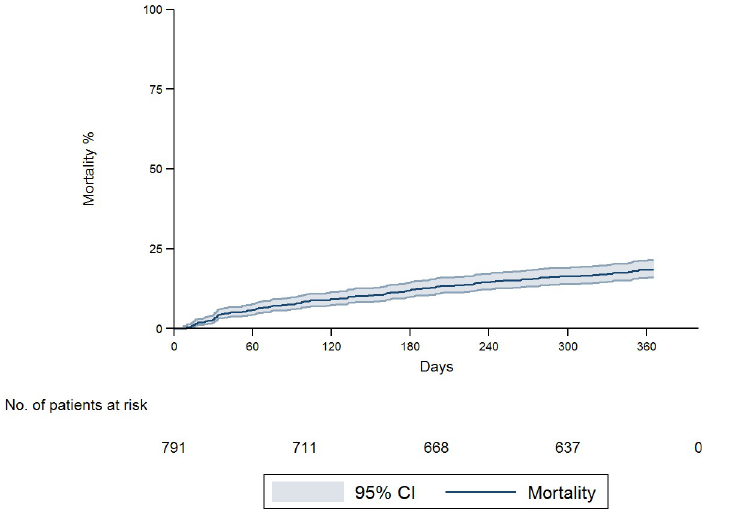
Fig 2. Overall 12-month